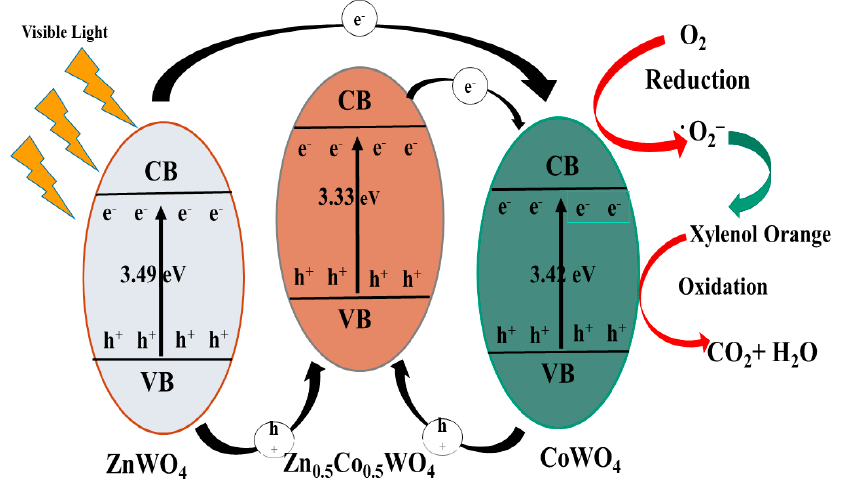
Figure 12. A plausible mechanism of degradation of XO by synthesized Zn 0.5 Co 0.5 WO 4 .